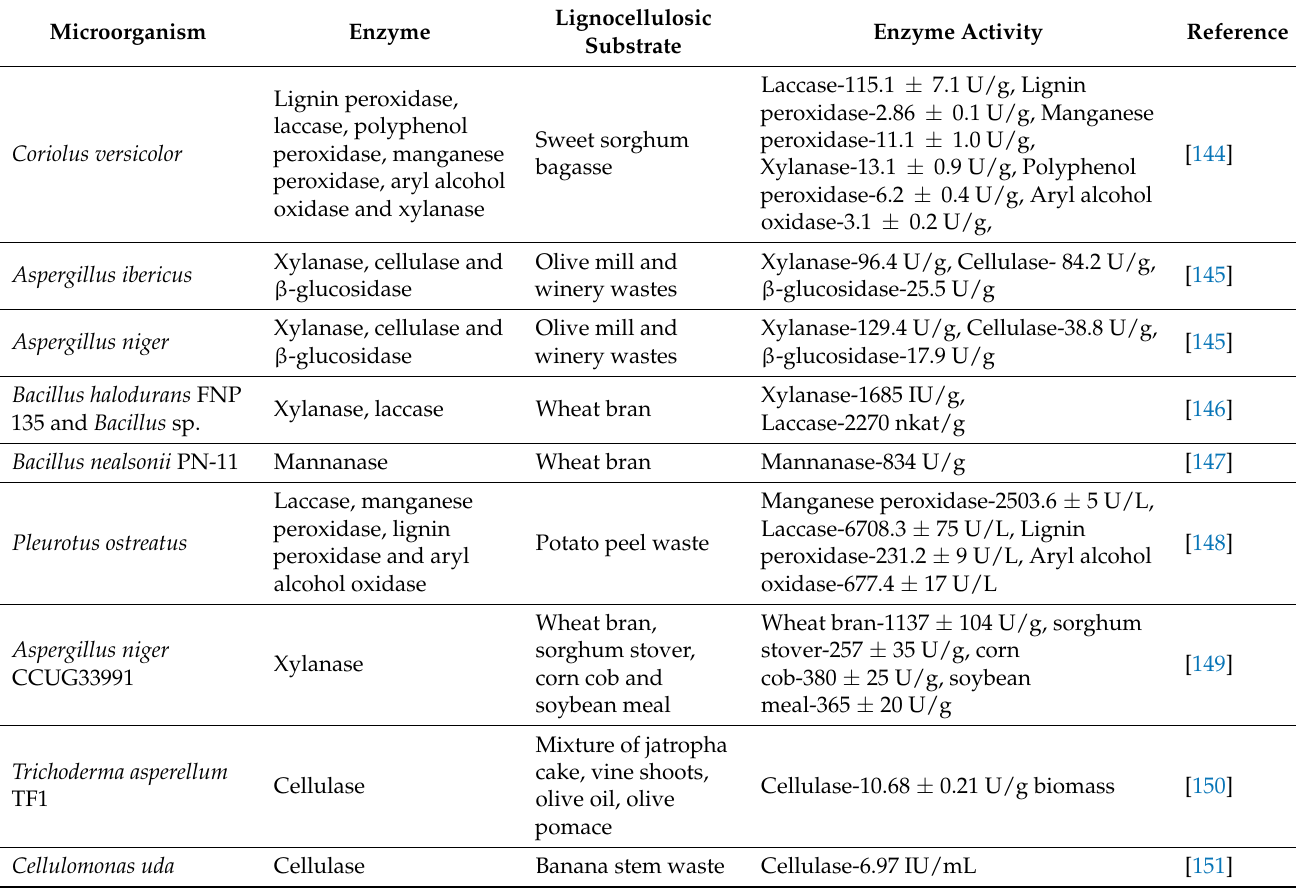
Table 2. Microbial enzyme production under SSF using lignocellulosic biomass as a